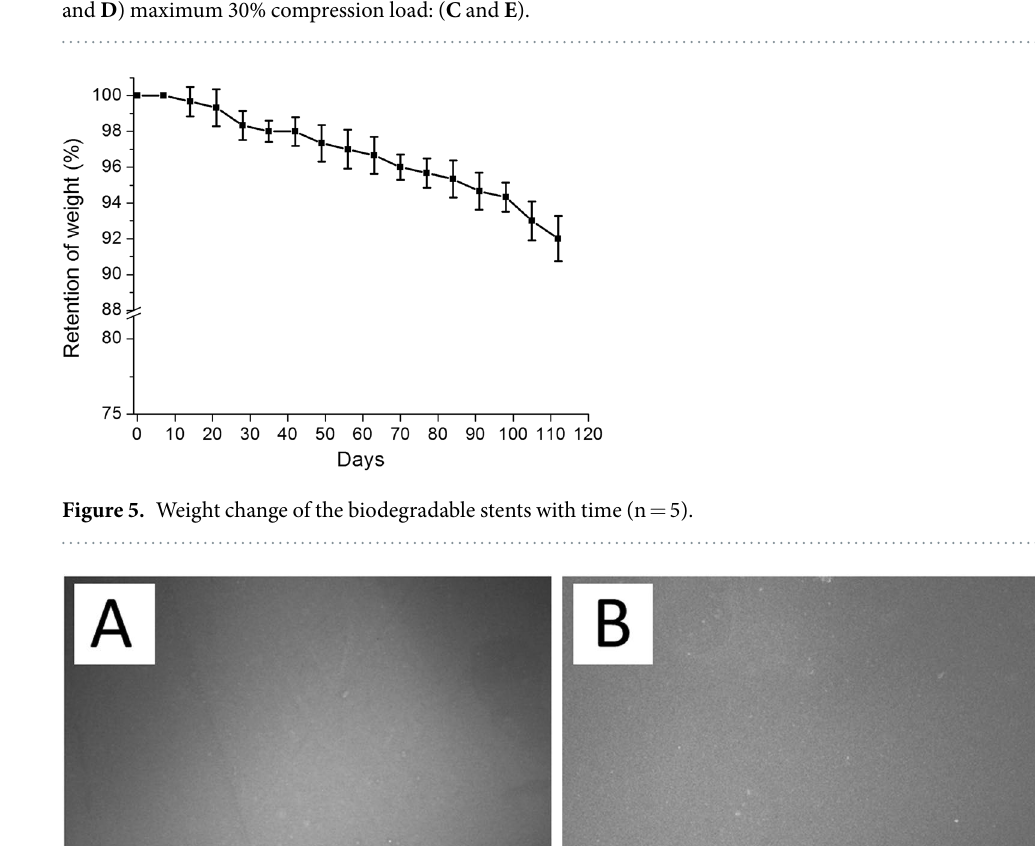
Figure 4. A comparison of the biodegradable stents (n = 5) and the metallic stents (n = 5) under the compression test ( A ) with maximum 30% compression strain (Initial diameter of the cable tie DES and BMS: ( B and D ) maximum 30% compression load: ( C and E ).